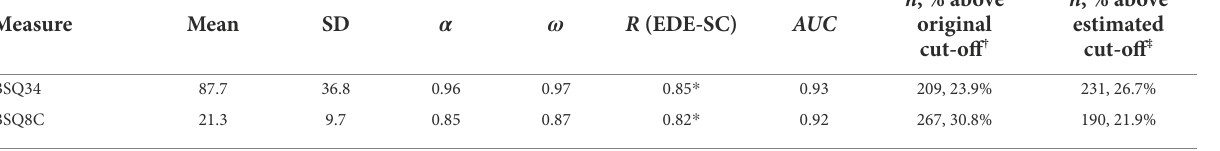
TABLE 2 Summary of reliability and validity measures of the Saudi BSQ34.